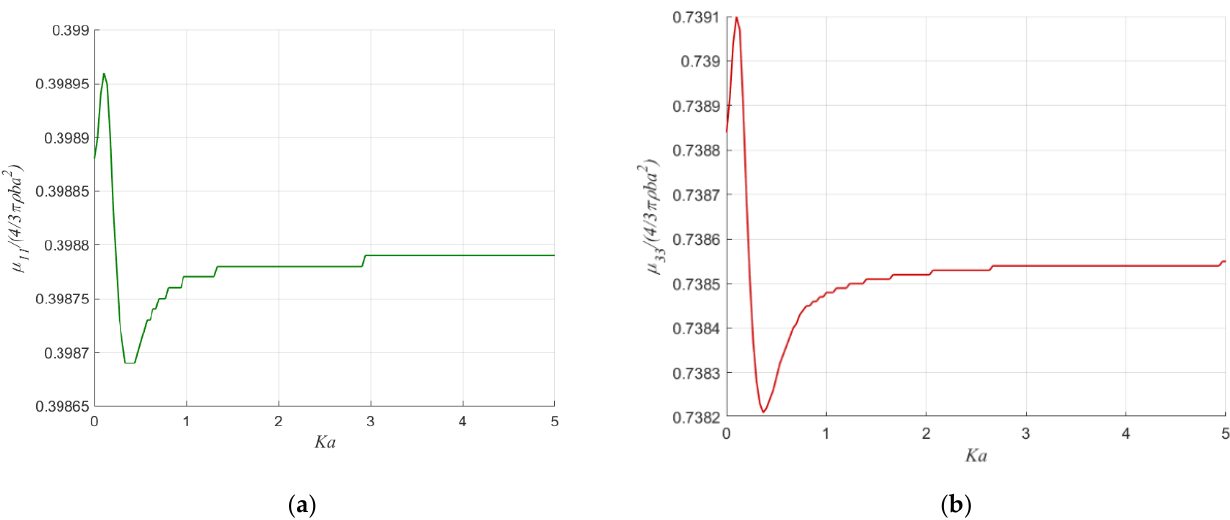
Figure 10. Normalized added mass for a/b = 1.1, f = 9a and h = 10a: ( a ) surge motion; ( b ) heave motion.